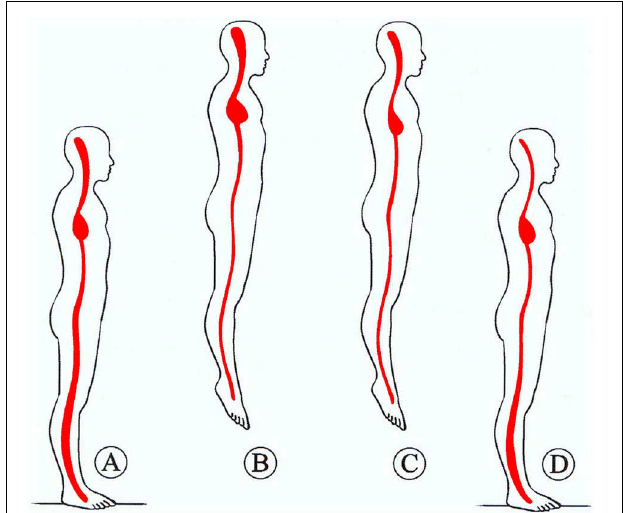
FIGURE 1 | Representation of central blood pooling in space. Upon transition from normogravity (A) to microgravity (B) the blood of the peripheral vascular space shifts to central space, causing central acute plethora, accompanied by peripheral vessel constriction. An adjustment is obtained by reduction of PV and RBC mass through erythrolysis and EPO reduction (C) over the first days of spaceflight. Then, upon return to normogravity (D) , the normal redistribution of blood volume and the augmentation of blood fluid reduce the haematocrit (space anemia). From Charles et al.